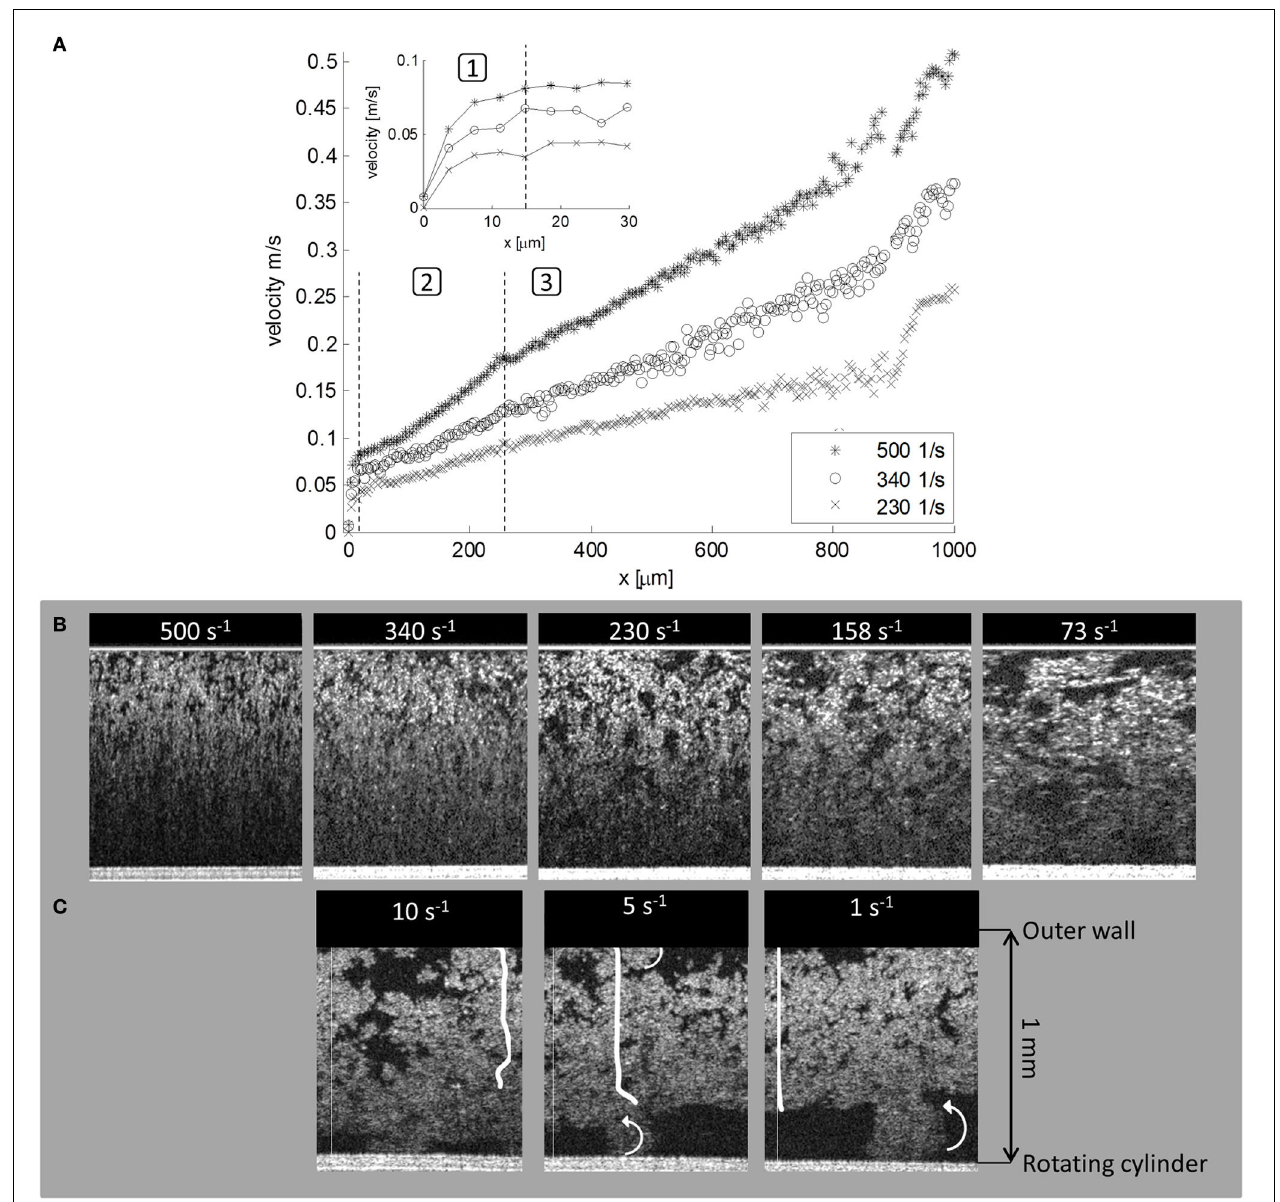
FIGURE 1 | OCT combined with a rotational rheometer equipped with smooth concentric cylinders geometry. (A) At high apparent shear rates the velocityprofilesof1%MFChavethreeregions:(1)Wallsliplayerwiththickness of ∼ 15 µ m. (2) Wall boundary layer ( ∼ 250 µ m) where the slope of the velocity profile is higher than in the middle of the gap. (3) The outer layer, where the shear rates are 55–70% smaller than the apparent shear rate. Close to the